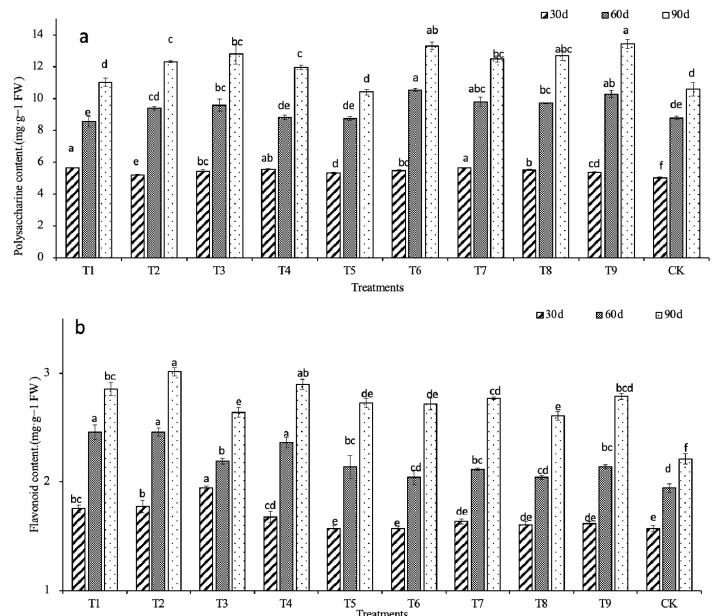
Figure 4. Effects on the content of main medicinal compounds. ( a ) Polysaccharide content. ( b ) Flavonoids content. Lowercase letters indicate inter group significance ( p < 0.05).